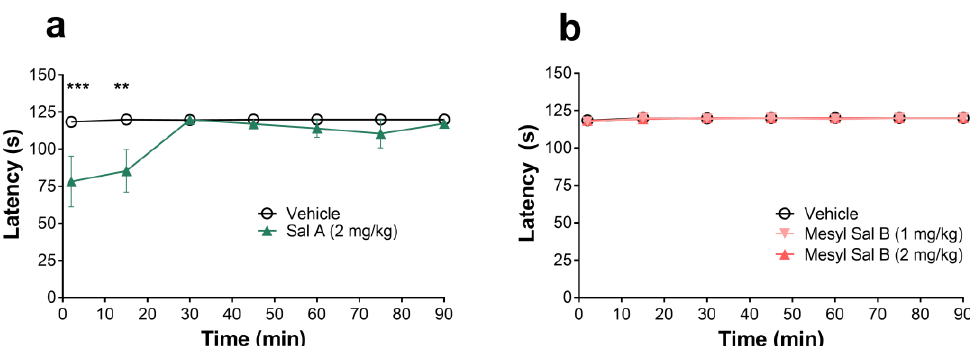
Figure 7. The rotarod motor coordination test in mice ( a ) Sal A shows a dose effect on motor impairment in the mouse with a decreased latency to fall (F(6,72) = 2.774, p = 0.0175). Post hoc analysis revealed 2 mg/kg Sal A causes significant motor impairment at 2 and 15 min. ( b ) Mesyl Sal B has no effects on the latency to fall in the rotarod test (F(12,96) = 0.1391, p = 0.9997). Two-way repeated measures ANOVA followed by the Bonferroni post-tests. Data presented as mean ± SEM; n = 6–7 for each group (** p < 0.01; *** p < 0.001 for 2mg/kg dose compared to vehicle).